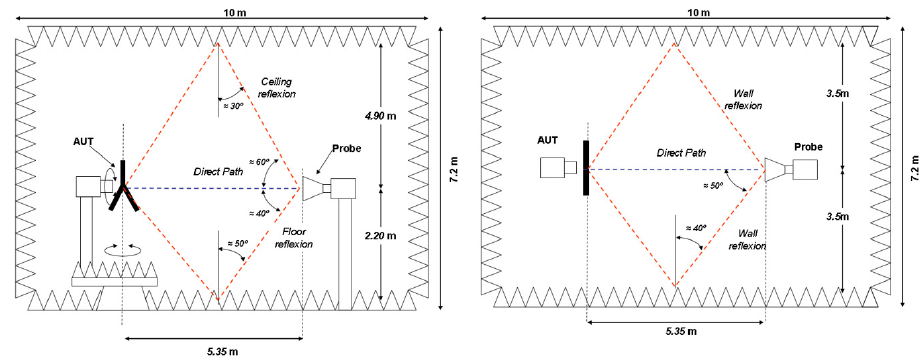
Figure A1. Antenna pattern measurement test setup in UPC anechoic chamber (https: // www.tsc.upc. edu / en / facilities /